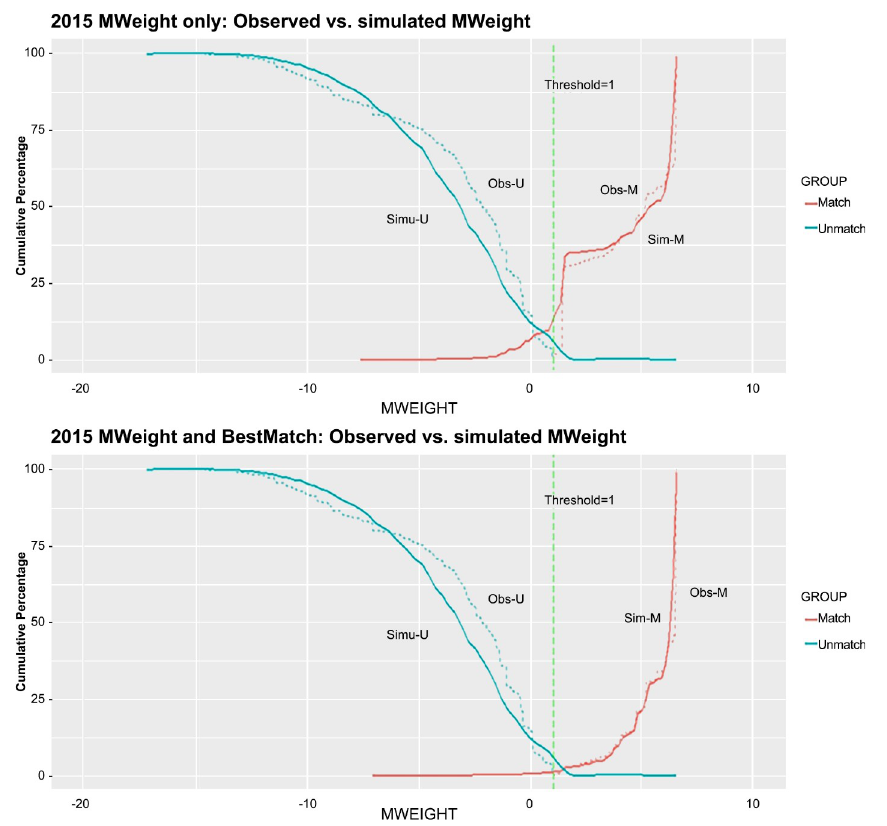
Fig 1. Cumulative distribution functions of the final match weight,